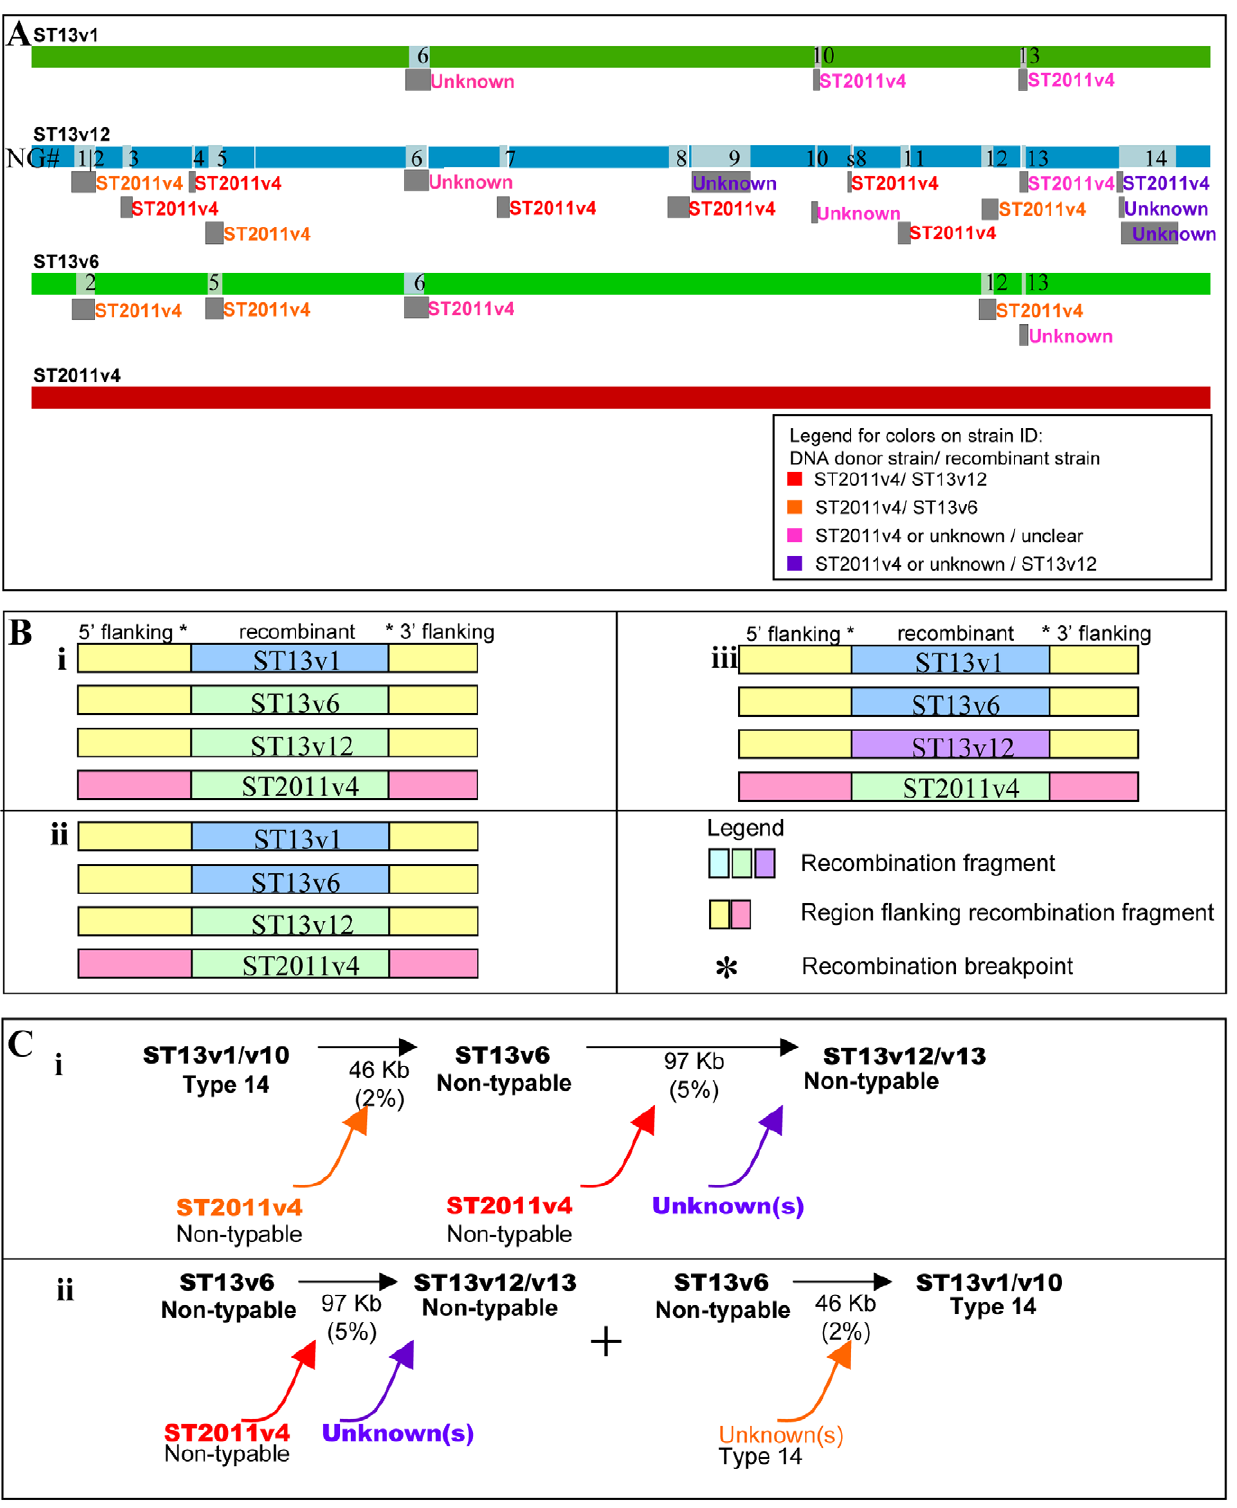
Figure 3. Identification of DNA donors for recombinant ST13 isolates. (A) RDP3-generated schematic of four genomes indicating evidence of recombination with neighbor group (NG) results superimposed. Light gray boxes within the whole genome sequence (WGS) schematic represent recombination events, and corresponding NG numbers have been inserted. Dark gray boxes are positioned below likely recombinant strains and are labeled with the most likely DNA donor for each transferred region. (B) Schematic illustrating the various patterns found in both the recombinant regions and surrounding areas. (i) Recombination fragments that are identical among ST2011v4, ST13v6, and ST13v12 while the surrounding regions are identical only among the ST13 strains (but contain SNPs relative to ST2011v4) (representative of NGs 5 and12 and corresponding to RDP D and L); (ii) Recombination fragments that are identical only between ST2011v4 and ST13v12 while the surrounding regions are identical only among the